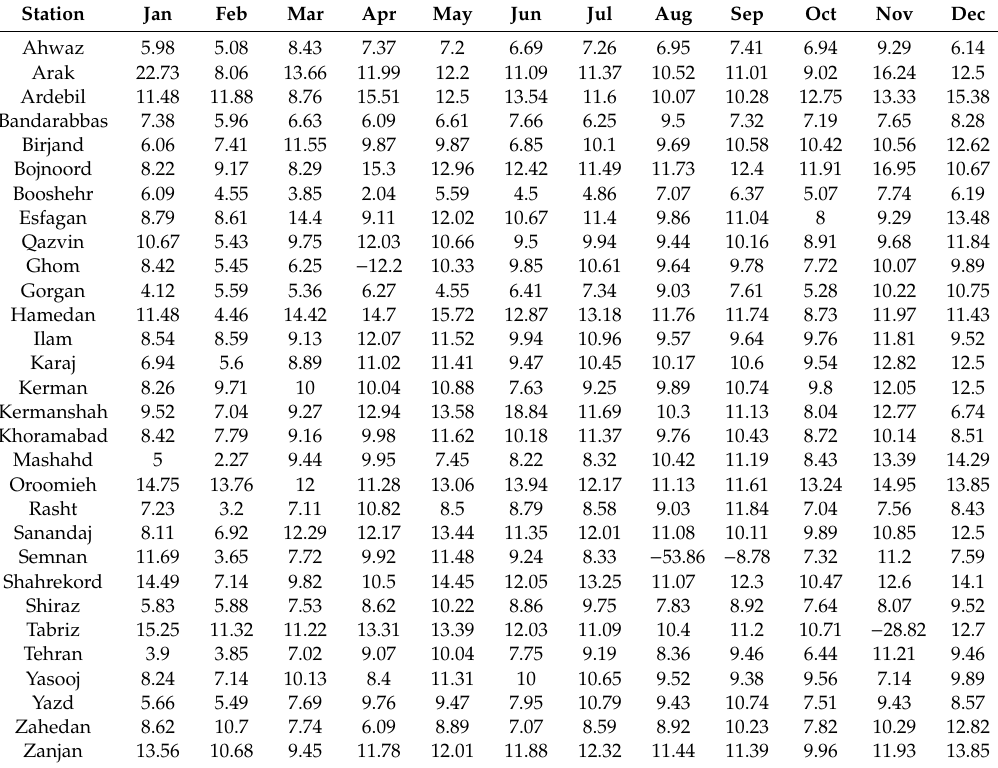
Table 7. Change percentages of the ET 0 predicted for the period from 2080 to 2113 under the A1B1 scenario.